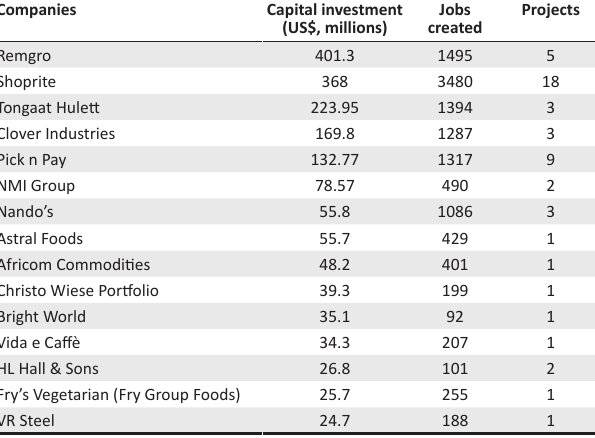
TABLE 7: Agricultural foreign direct investment outflows from South Africa by company, 2003–2014. Companies